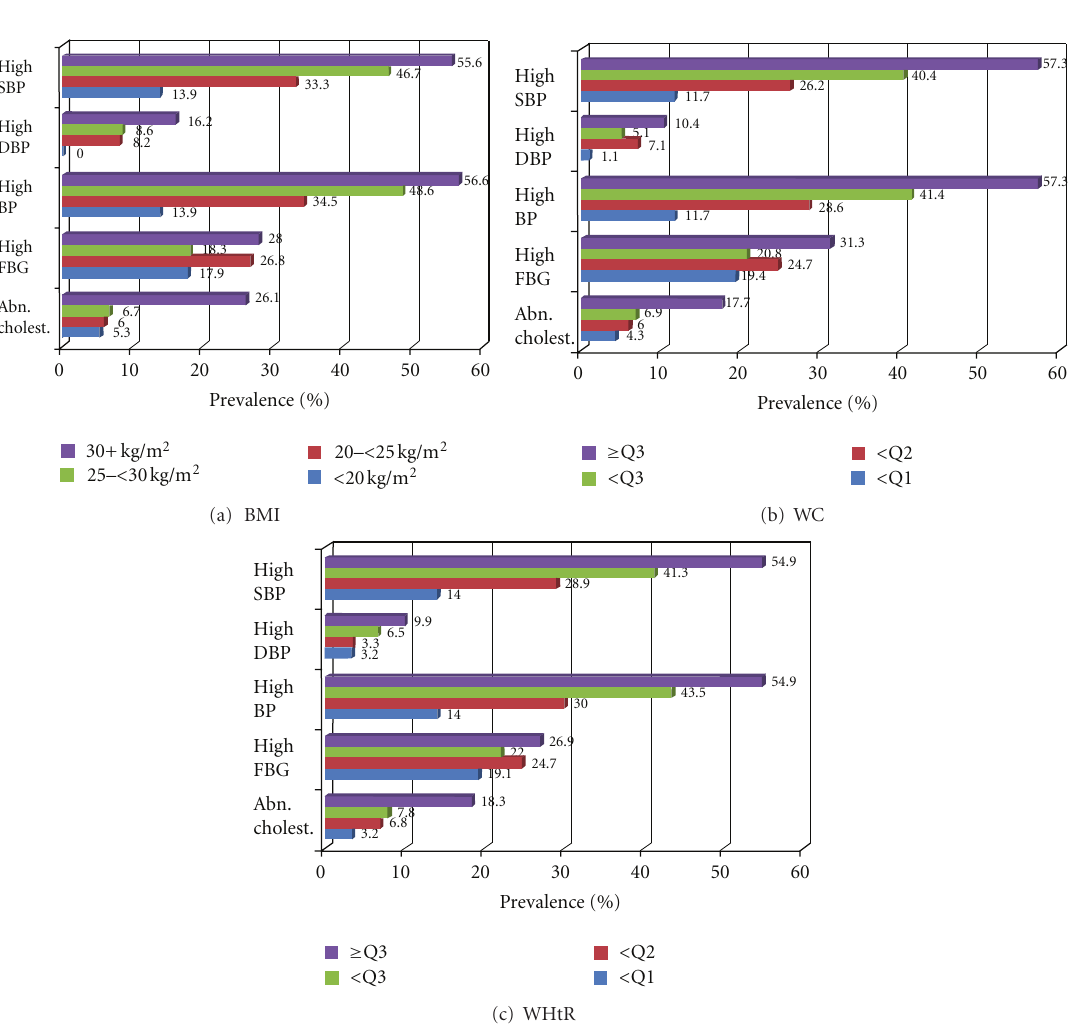
Figure 3: Prevalence of individual metabolic syndrome abnormalities in relation to (a) BMI, (b) WC, and (c) WHtR obesity indicators among Saudi college